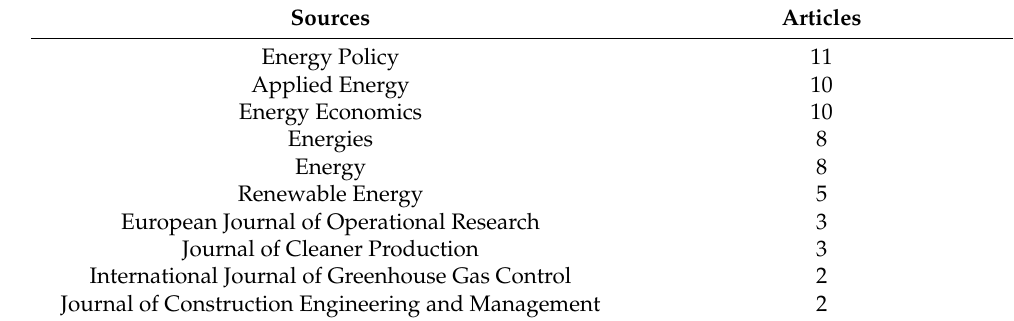
Table 14. Papers by Source (ROA).